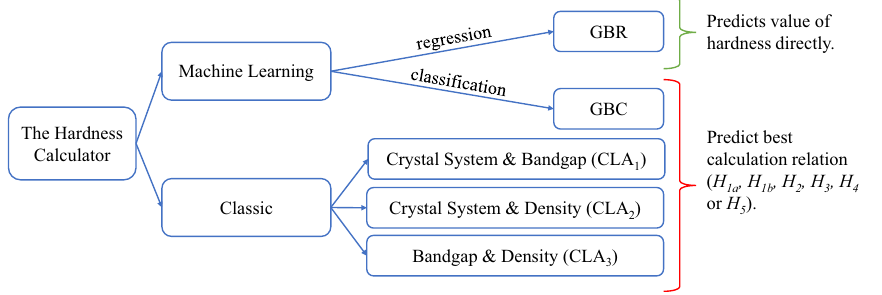
Figure 1. Conceptual diagram of the hardness